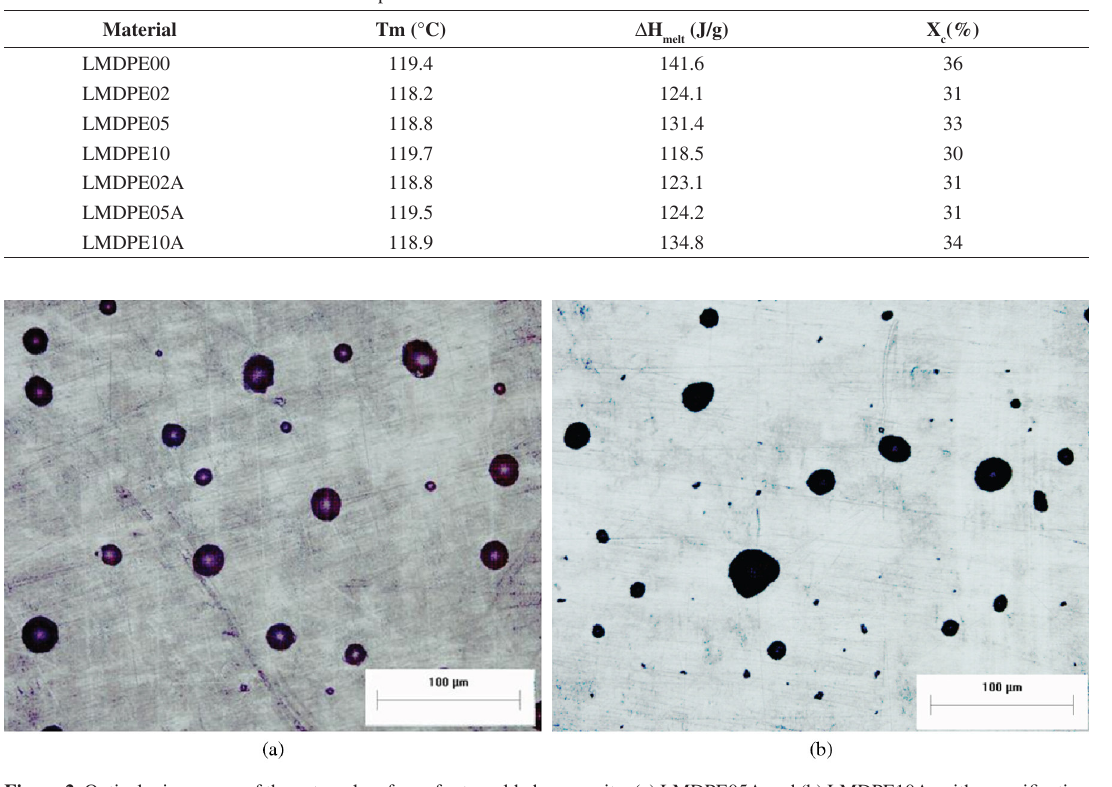
Figure 2. Optical microscopy of the external surface of rotomolded compositeI: (a) LMDPE05A and (b) LMDPE10A, with magnification of